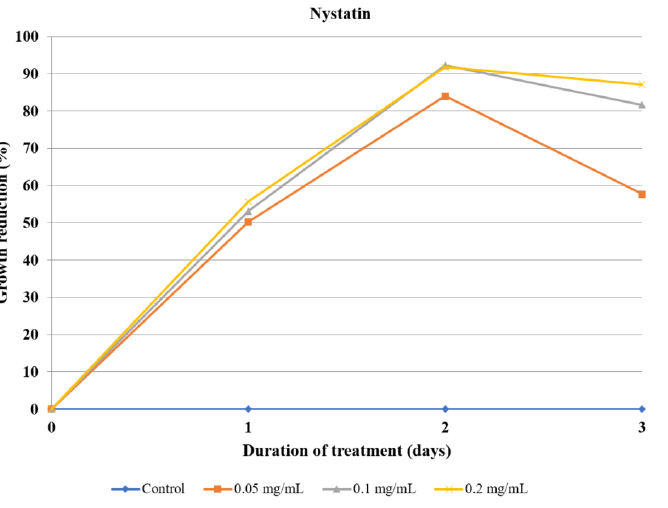
Figure 7. The effect of nystatin used as a positive control on the inhibition of Acanthamoeba trophozoite proliferation in the culture medium.